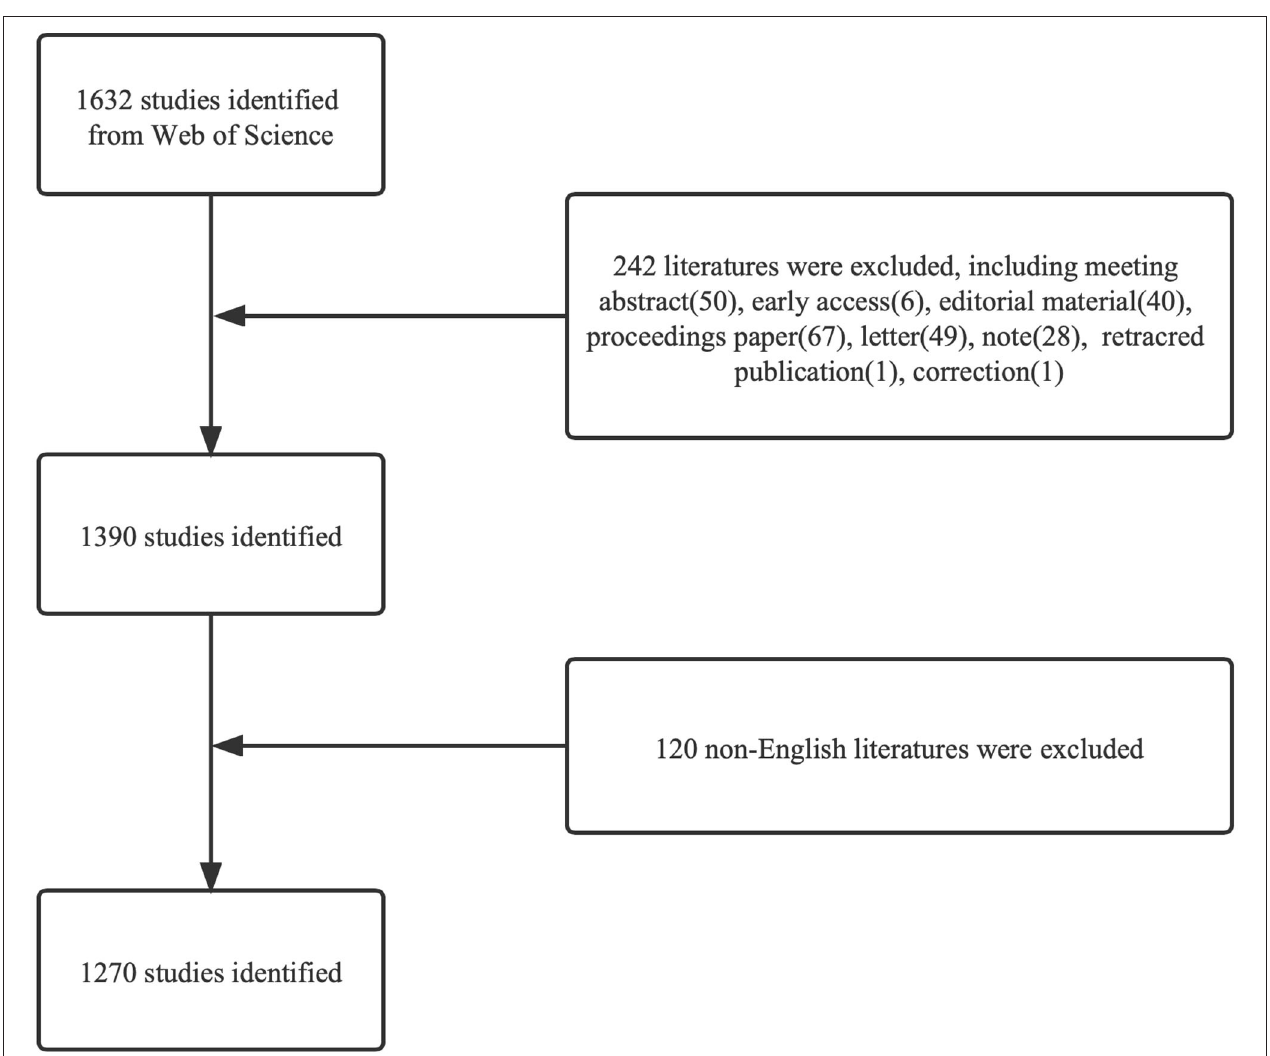
FIGURE 1 | Flowchart of the screening